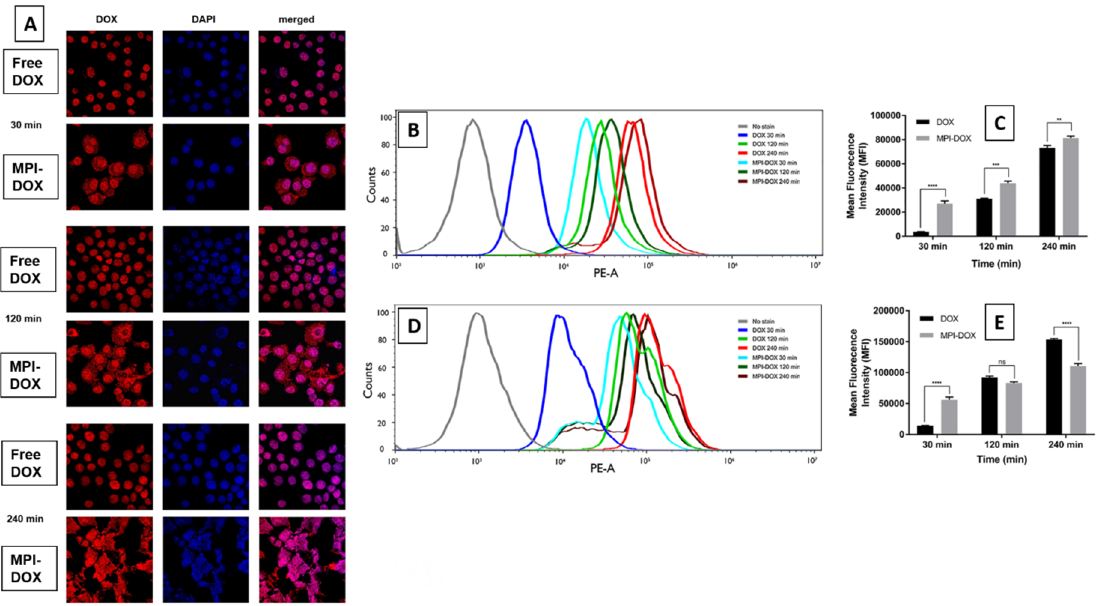
Figure 5. ( A ) CLSM image of RAW 264.7 cells incubated with free doxorubicin and MPI-doxorubicin for various times. For each panel, the images from left to right show fluorescence of doxorubicin in cells (red), cell nuclei stained by DAPI (blue), and overlays of two images. Flow cytometry analysis of doxorubicin fluorescence intensity incubated with free doxorubicin and MPI-doxorubicin at an equivalent concentration of doxorubicin at 50 µg/mL under 37 °C for 30, 120, and 240 min. The bar length represents 10 µm. ( B ) histogram profile of RAW cells; ( C ) mean fluorescence intensity (MFI) in RAW cells; ( D ) histogram profile of HCT 116 colon cancer cells; ( E ) mean fluorescence intensity (MFI) in HCT 116 cells. The data are expressed as the mean ± SD ( n = 3), ** P < 0.01, *** P < 0.001 and **** P < 0.0001 (two-way or one-way ANOVA, Tukey’s test).